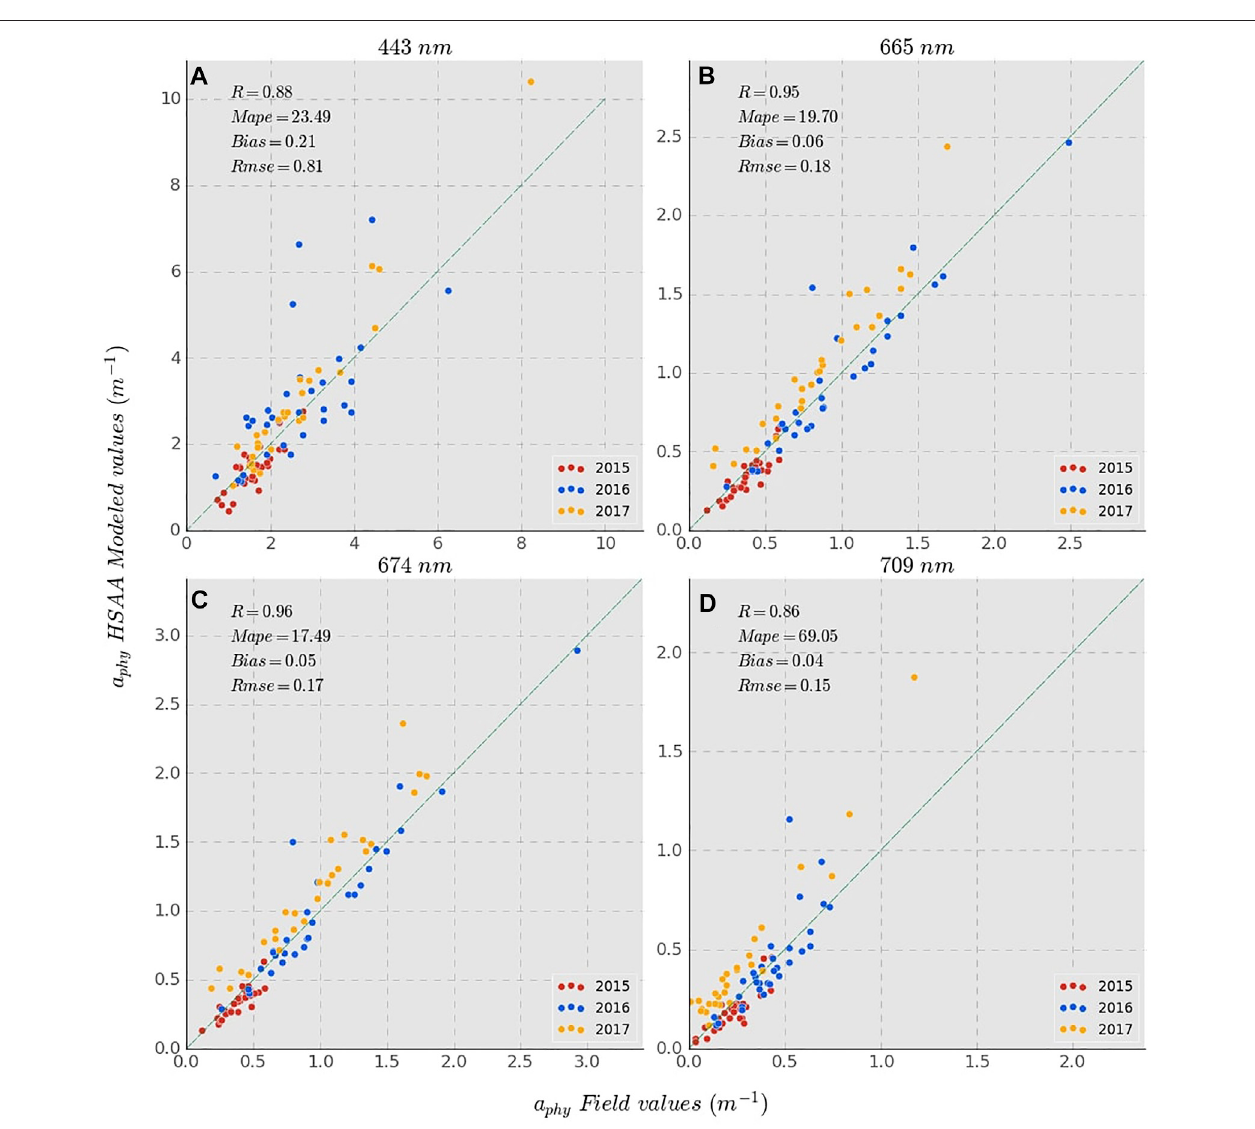
FIGURE 6 | α phy ( λ ) retrieval for HSAA at (A) 443 nm, (B) 665 nm, (C) 674 nm, and (D) 709 nm.